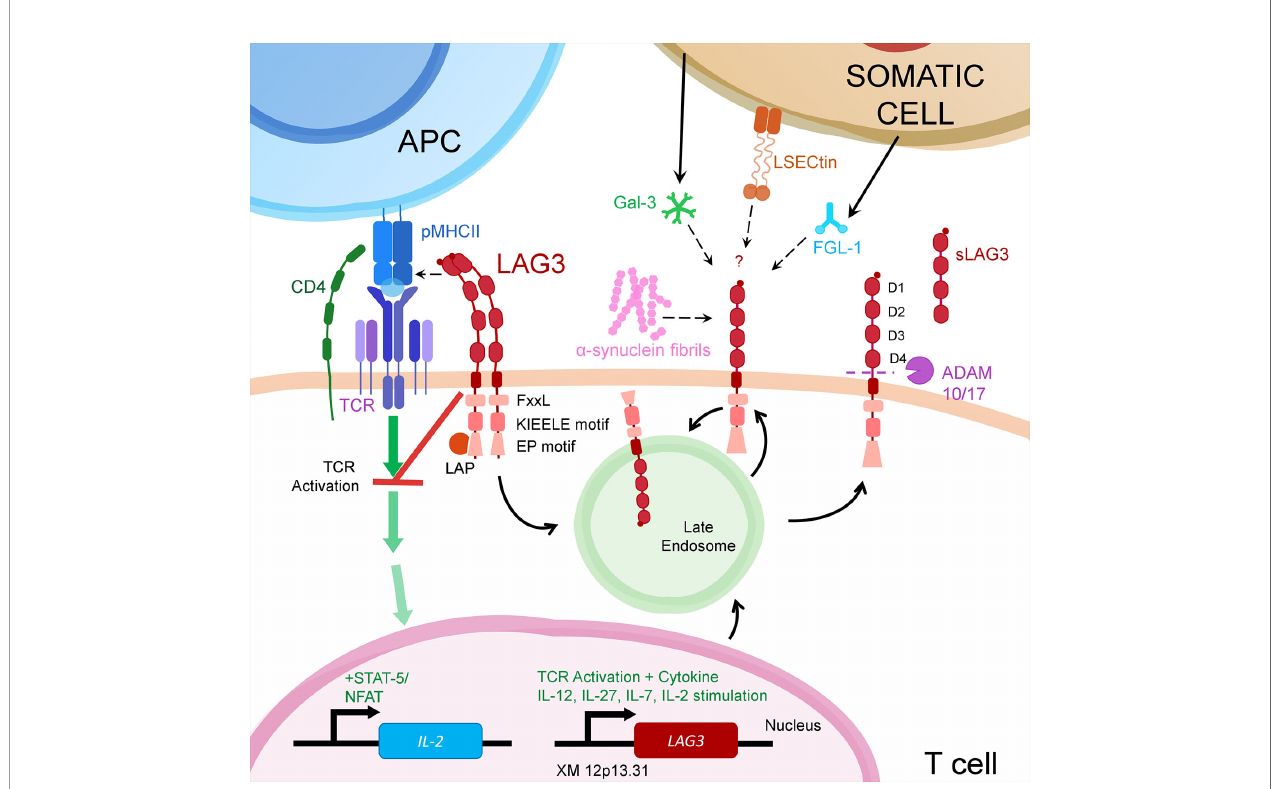
FIGURE 1 | LAG3 transcription is upregulated following activation through the T cell Receptor (TCR) or from certain cytokines. Once translated, LAG3 resides in late endosomes for subsequent traf fi cking to the cell surface.There, LAG3 exists as an oligomer or monomer. While seemingly necessary for MHCII binding, LAG3 oligomerization may or may not be required for interaction with other LAG3 ligands ( a -syn, Gal-3, L-SECtin or FGL-1). Upon ligand binding, LAG3 inhibits early steps of the TCR pathway in a manner dependent on LAG3 ’ s cytoplasmic domain. This prevents activation of transcription factors, including NFAT, thereby decreasing cytokine production and proliferation. LAG3 surface expression is regulated by metalloproteases ADAM10/17 that proteolytically cleave LAG3, releasing it in soluble form (sLAG-3). LAG3 surface expression may also be regulated by endocytosis, which can be accelerated by ligand